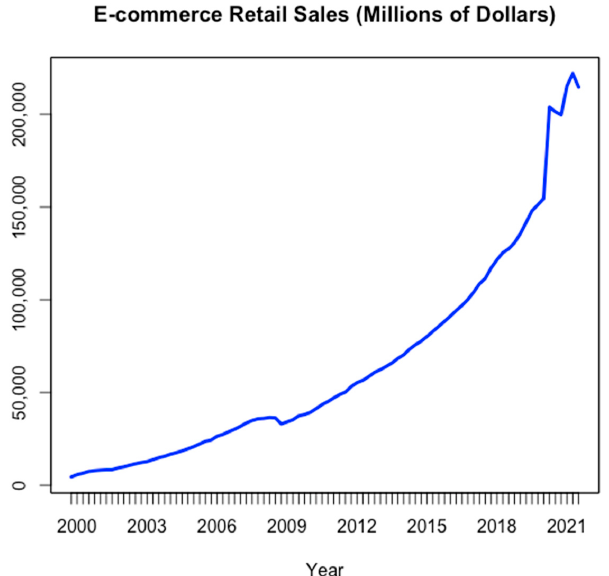
Figure 2. Quarterly evolution of E-Commerce Retail Sales [ECOMSA] over 1999–2021; Author’s representation with data retrieved from the Federal Reserve Bank of St. Louis (FRED), which sources data from U.S. Census Bureau; https://fred.stlouisfed.org/series/ECOMSA; accessed on 8 September